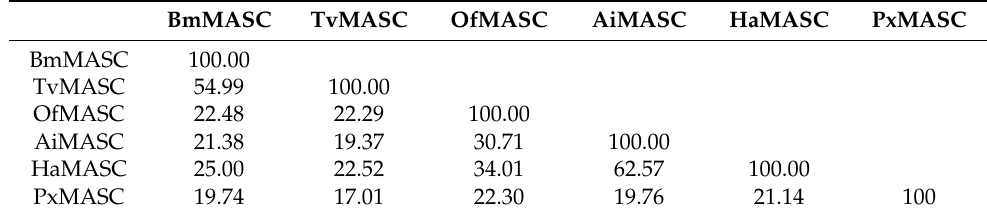
Table 1. Amino acid sequence identity among lepidopteran Masc proteins.